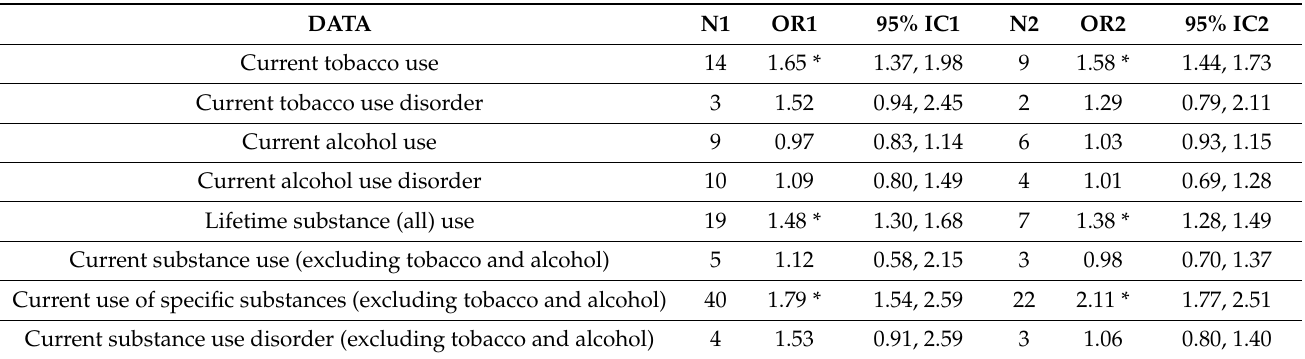
Table 2. Summary of the